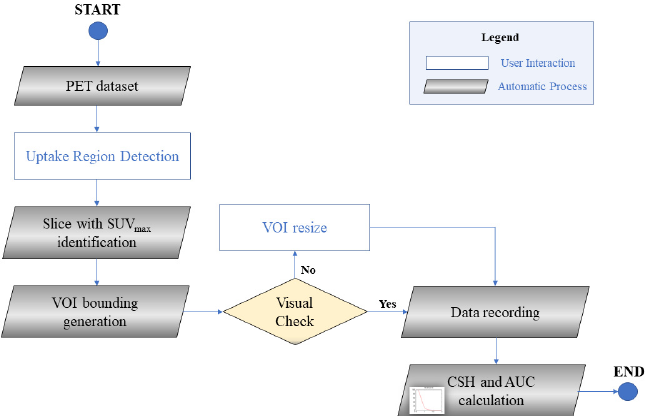
Figure 2. Flow diagram of the proposed semiautomatic approach to calculate CSH and AUC parameters. Adopted graphical and color notations are explained in the legend box.